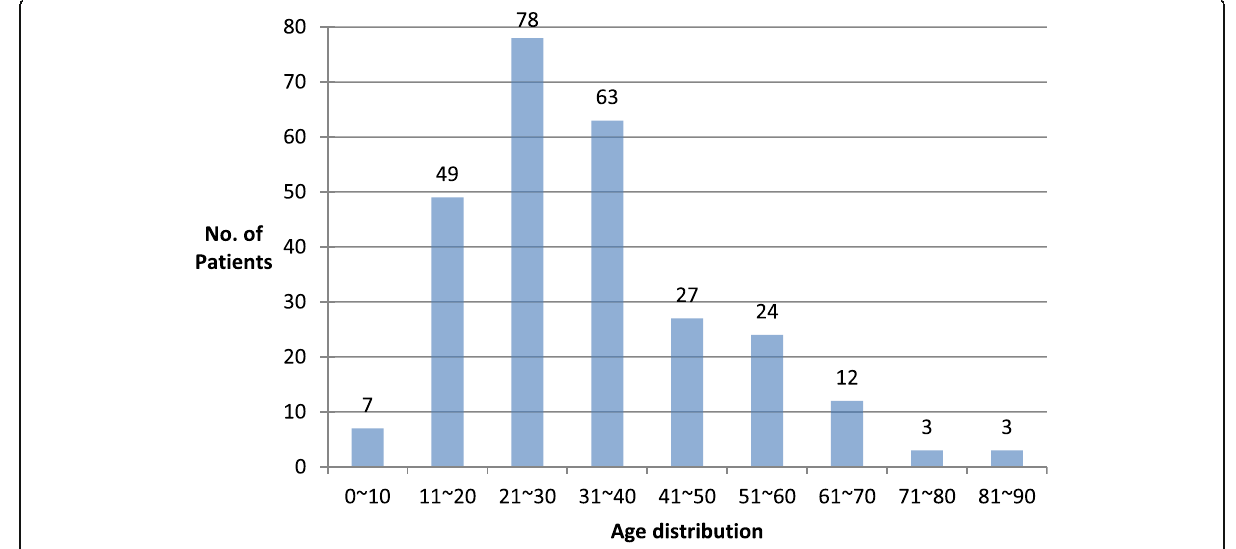
Fig. 2 Age distribution in patients with odontogenic keratocyst